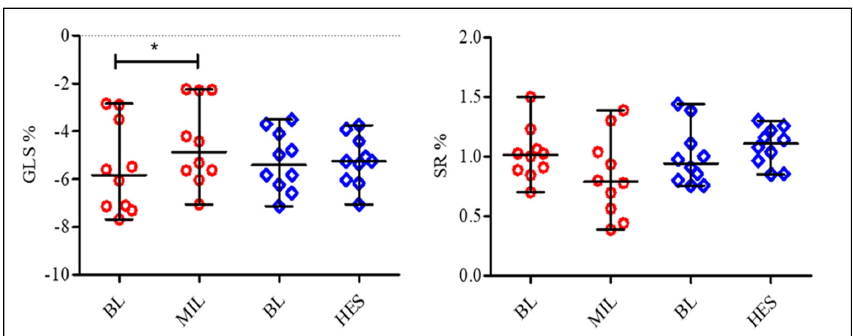
Figure 2. Effect of various loading conditions on 2DSTE measurements. Plots showing the median (central horizontal line) and range ( n = 10, for each experiment). BL, baseline; MIL, milrinone; HES, hydroxyethyl starch; SR, strain rate; GLS, global longitudinal strain. * p < 0.05 compared with BL.